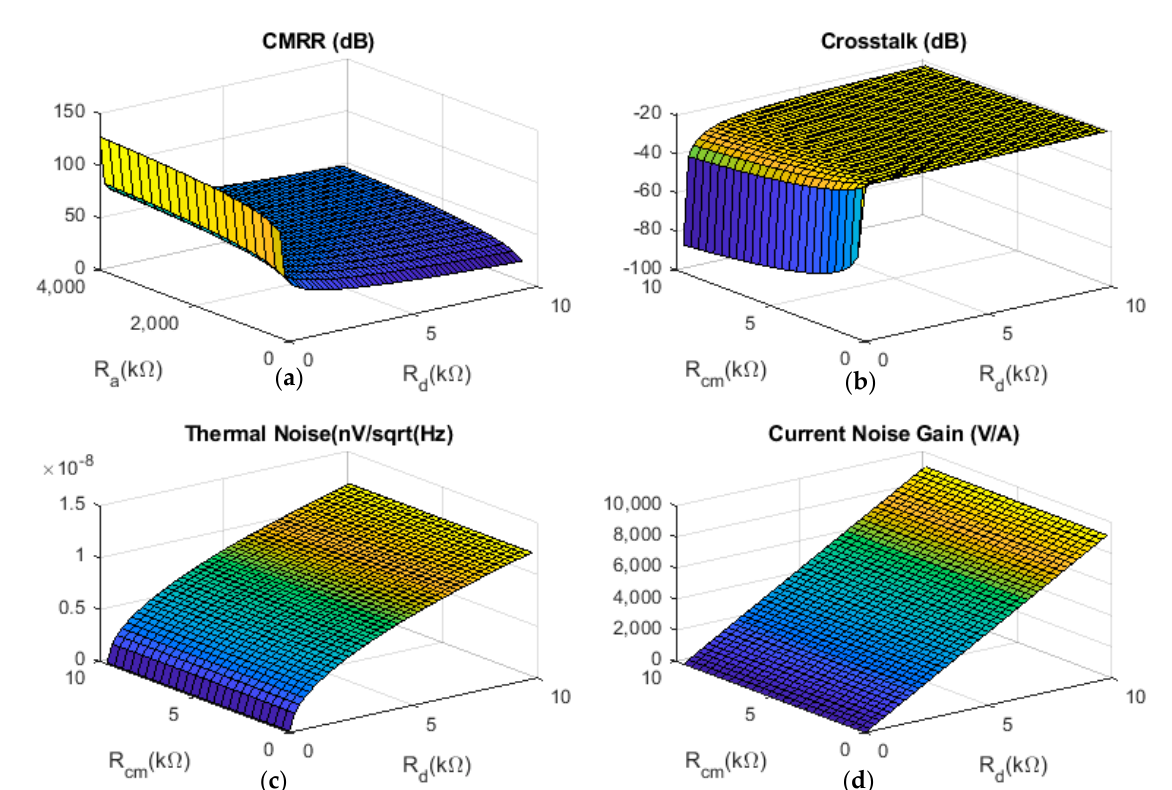
Figure 8. The effect of design parameters on ( a ) CMRR; ( b ) crosstalk; ( c ) thermal noise and ( d ) current noise gain. This 3D presentation of the material from Sections 2 and 4 is discussed in Section 5.